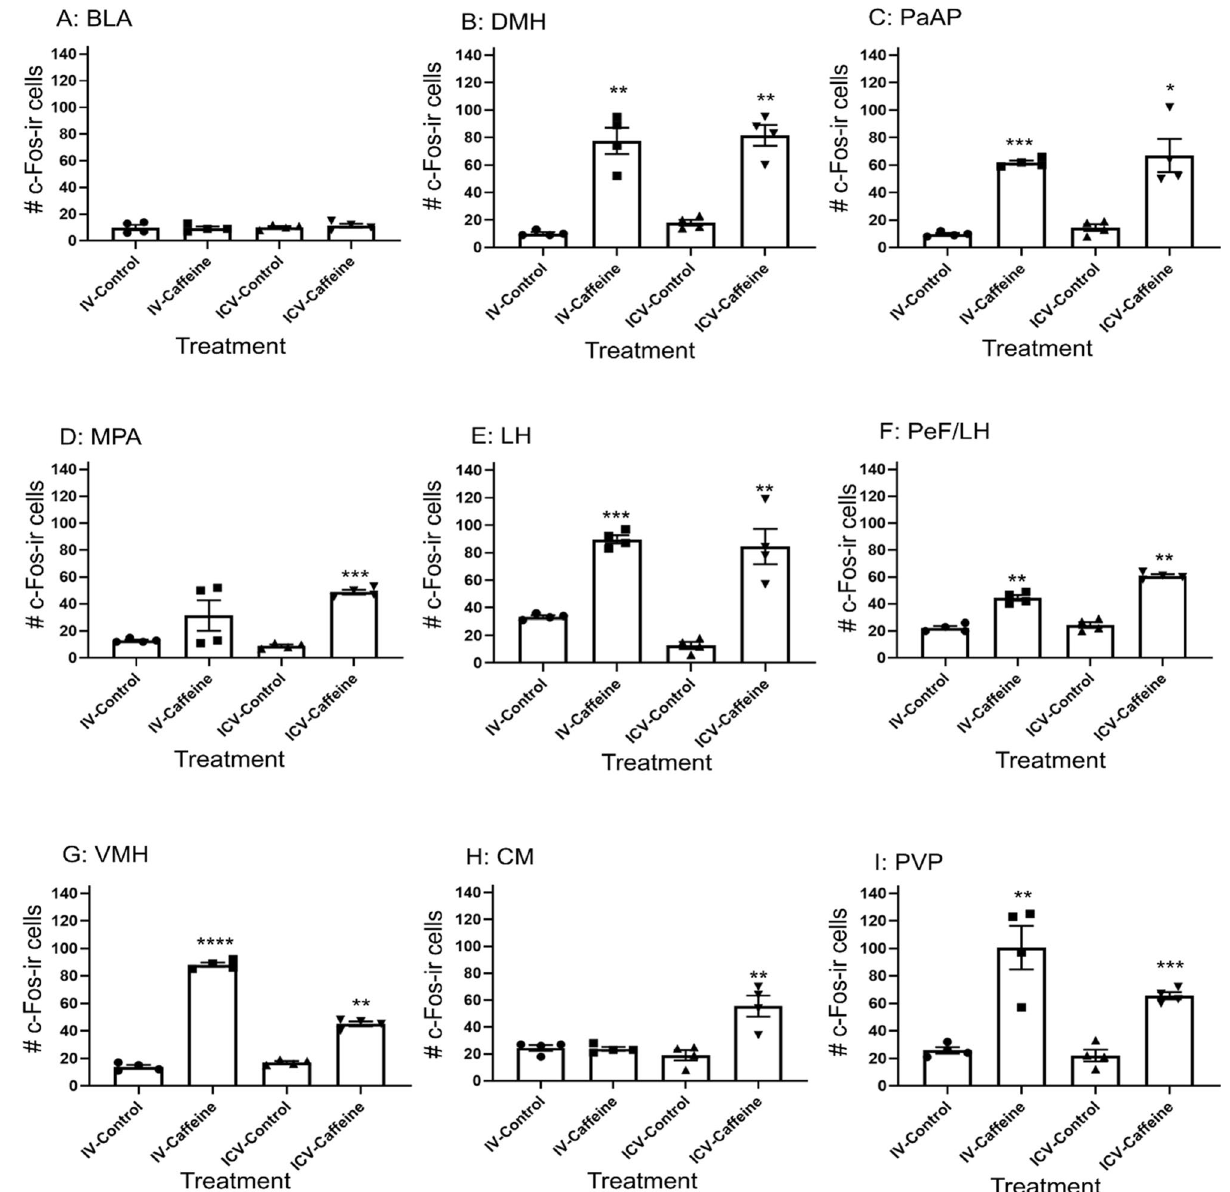
( F ) PeF/LH, ( G ) VMH, ( H ) CM, ( I ) PVP. Graphs illustrate the mean difference in number of c-Fos-ir neurons following administration of caffeine or control. Error bars represent S.E.M., n = 4, represents caffeine effect * p < 0.05; ** p < 0.01; *** p < 0.001; **** p < 0.0001. Analysis conducted separately for IV and ICV administration. BLA basolateral amygdala, PaAP paraventricular hypothalamic nucleus, MPA medial preoptic area, VMH ventromedial hypothalamus, CM central medial thalamus, PVP paraventricular thalamic nucleus